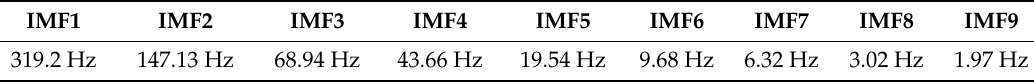
Figure 8. The EMD and EEMD results for noisy signal. Table 5. The frequency distribution of IMFs by EMD.